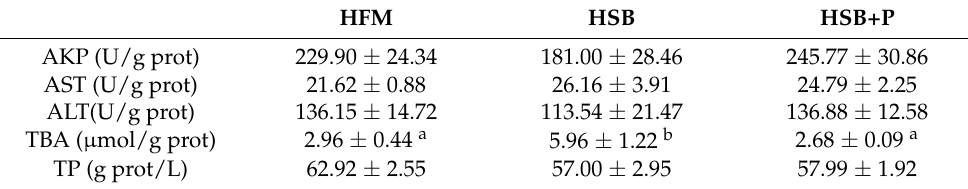
Table 6. Effects of experimental diets on liver function of largemouth bass (Mean ± SEM, n =